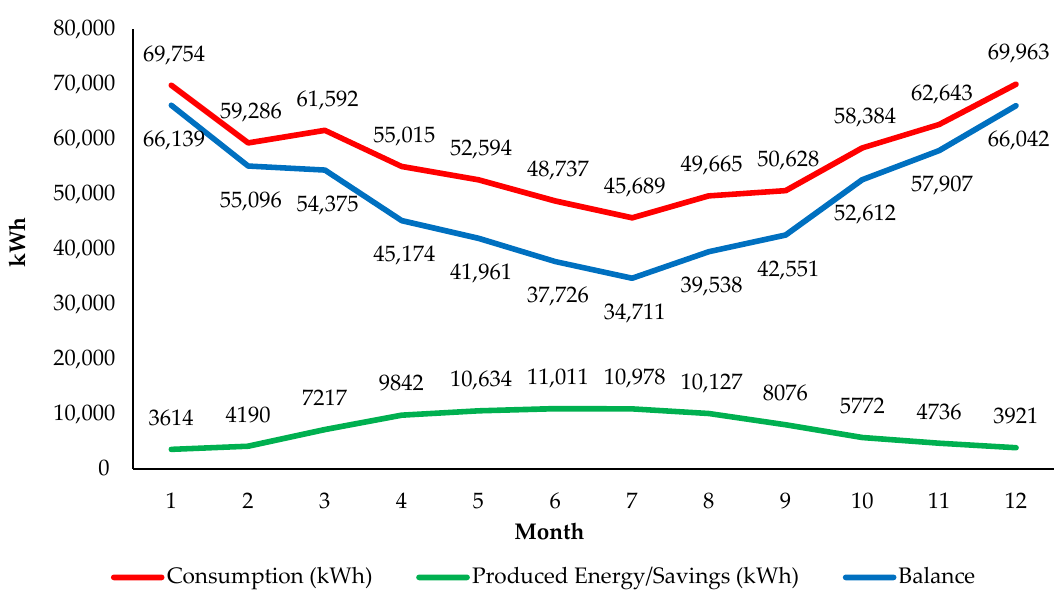
Figure 12. Monthly energy balance.